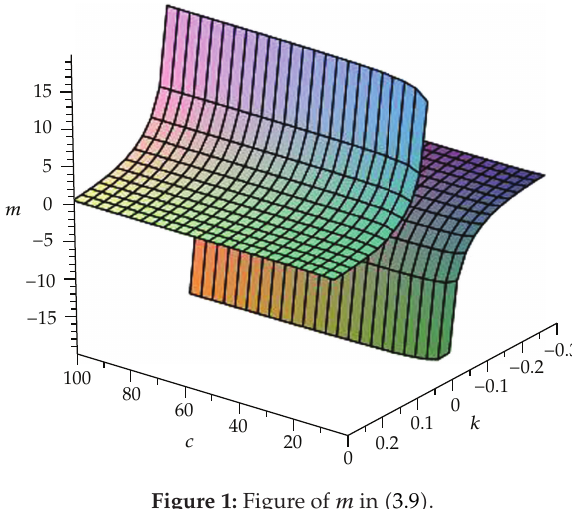
Figure 1: Figure of m in (cid:3) 3.9 (cid:4) .